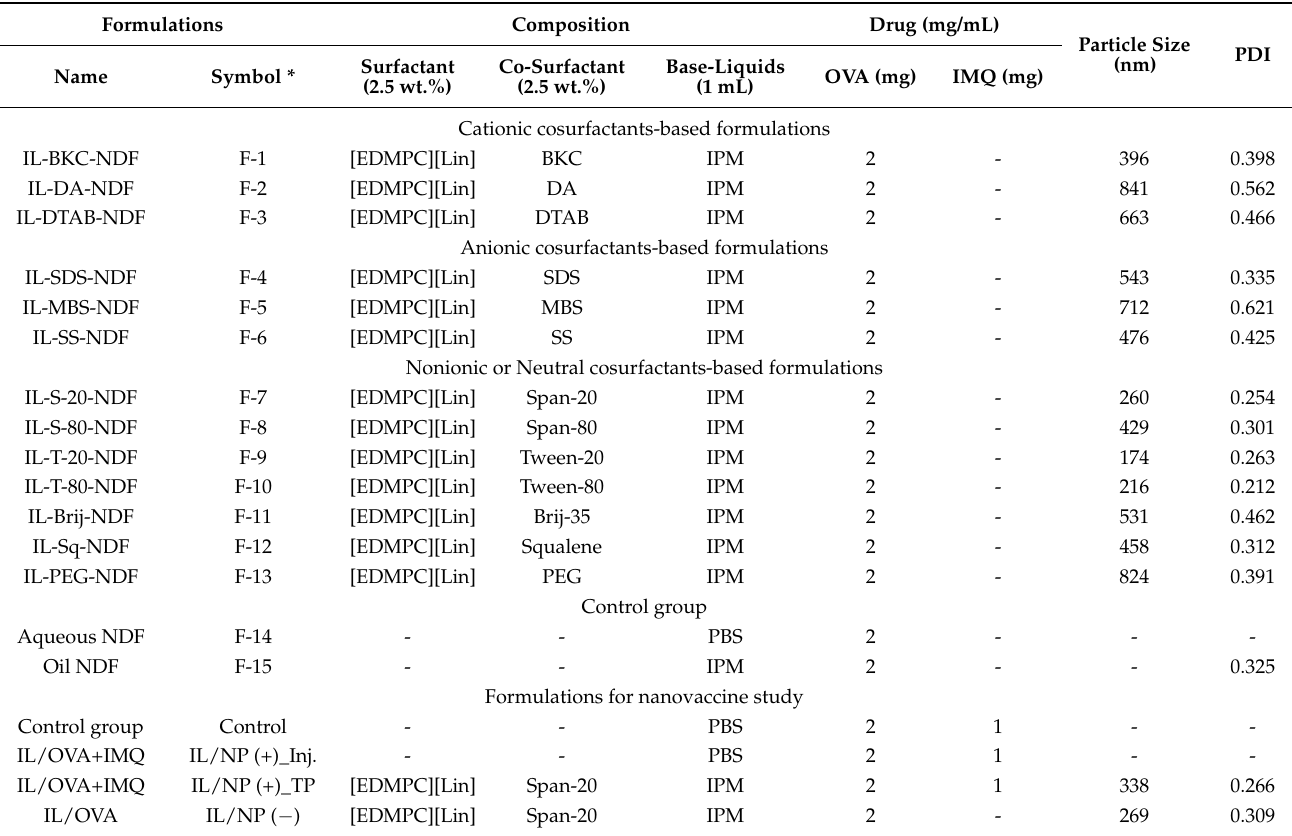
Table 1. Particle size and PDI of IL-containing conventional surfactant-based protein- and/or immunomodulator-containing